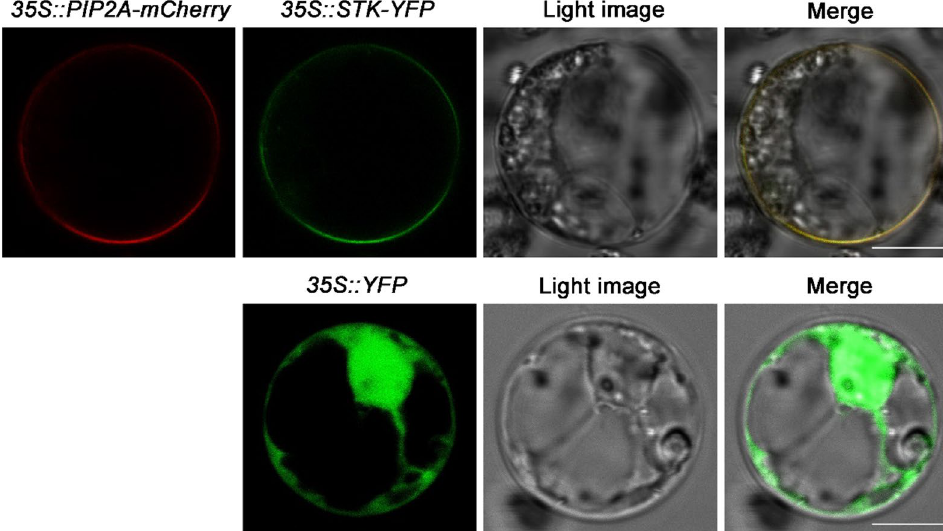
Fig. 2 Subcellular localization of STK in rice protoplast. 35S::STK-YFP and 35S::PIP2A-mCherry were cotransformed into rice etiolated shoot protoplasts. 35S::YFP was transformed as control. Bar